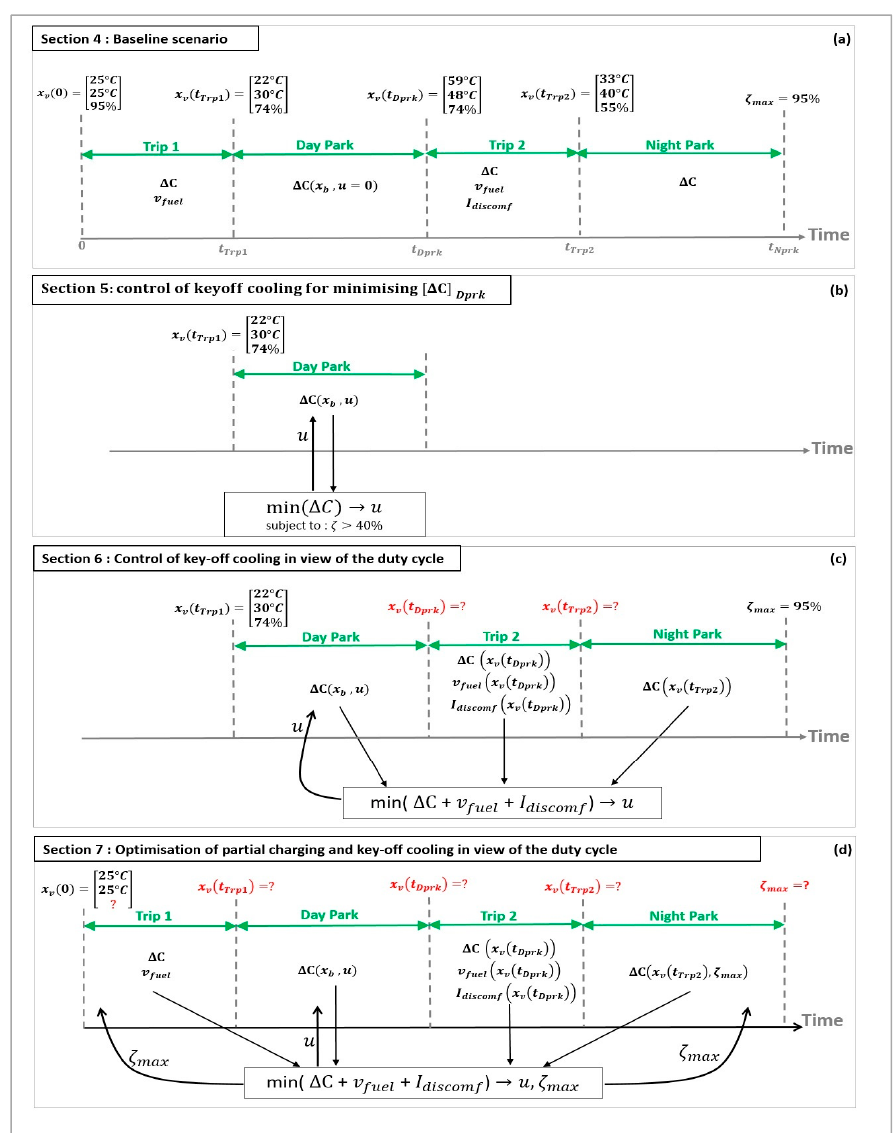
Figure 7. Organization of Sections 4–7 of this paper. The variables highlighted in red are evaluated or defined during the execution of the optimization algorithm. ( a ) Section 4, baseline scenario; ( b ) Section 5, key-off cooling for minimizing ∆ C Dprk ; ( c ) Section 6, key-off cooling in view of complete duty cycle; and ( d ) Section 7, key-off cooling and partial charging.